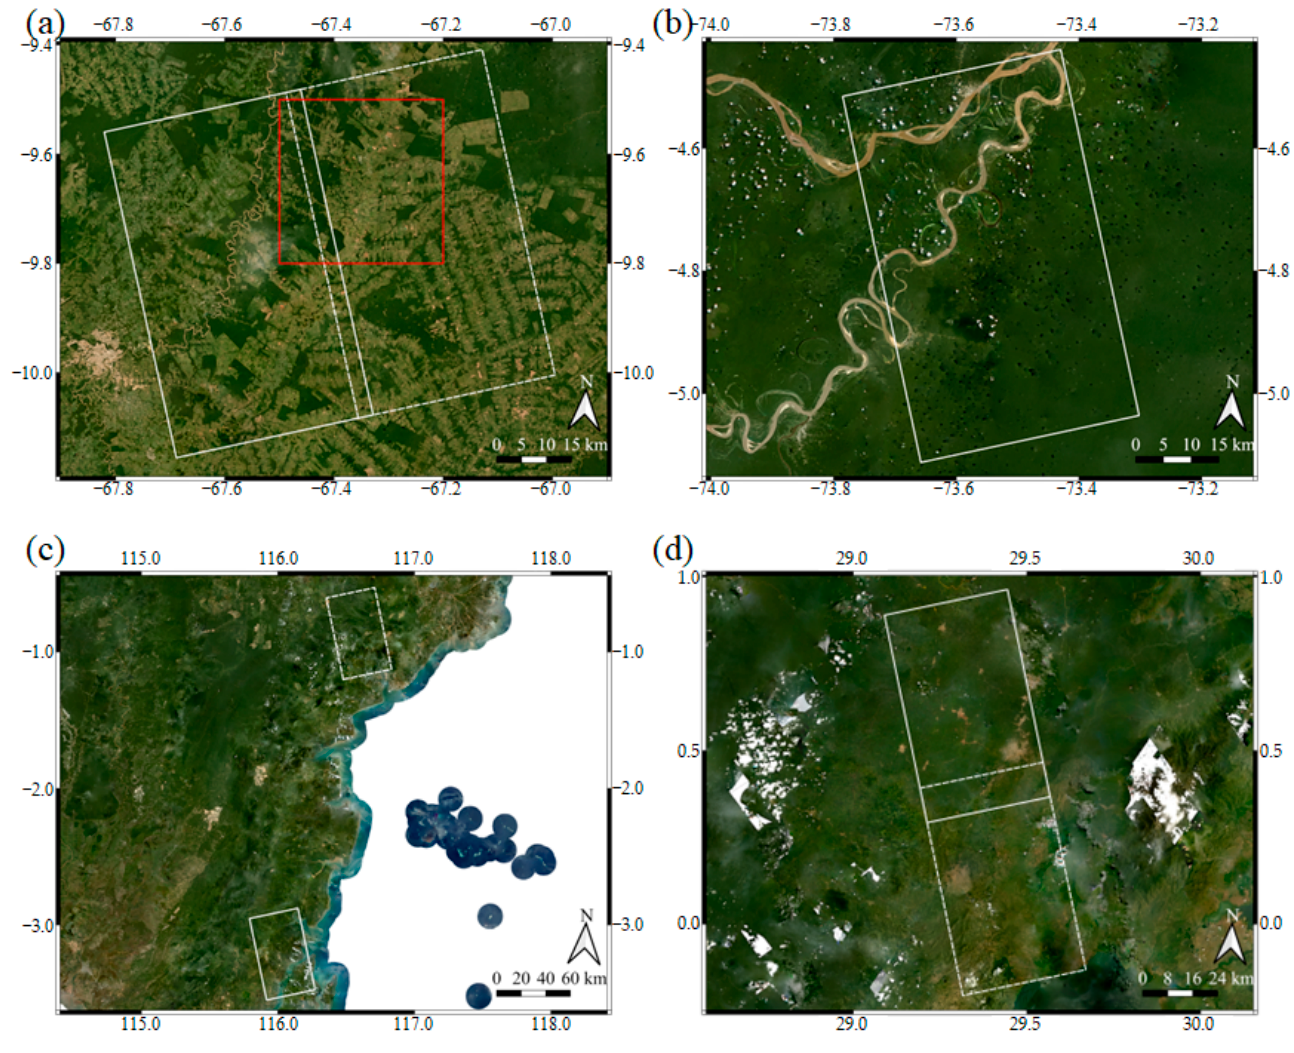
Figure 1. Study sites: ( a ) Rio Branco in Brazil, ( b ) Ucayali River in the Amazon, ( c ) Kalimantan in Indonesia, and ( d ) Congo Basin in the Republic of the Congo. The white solid and dotted rectangles indicate subareas A and B, respectively. The red square in ( a ) shows the reference data area described in Section 2.1.2. The mosaic images used as the base map were acquired by Planet/Dove in